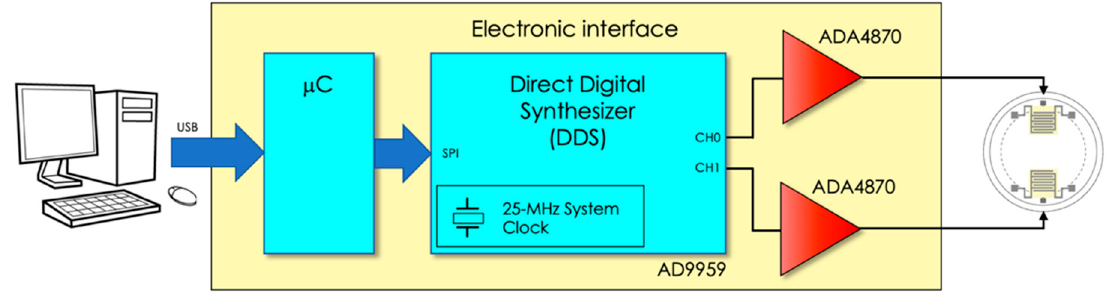
Figure 5. Block diagram of the tailored electronic interface used to drive the actuators.